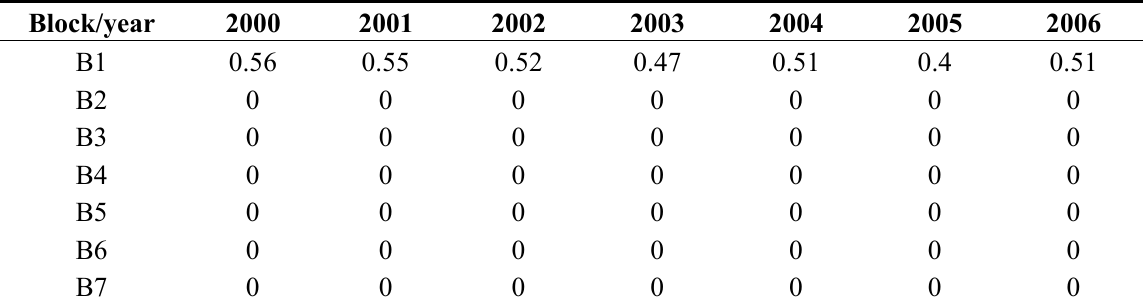
Table 4. Direct/apparent Water Productivity (DWP) in the Castile and León Region, 2000–2006 (€/m 3 , constant prices), irrigation